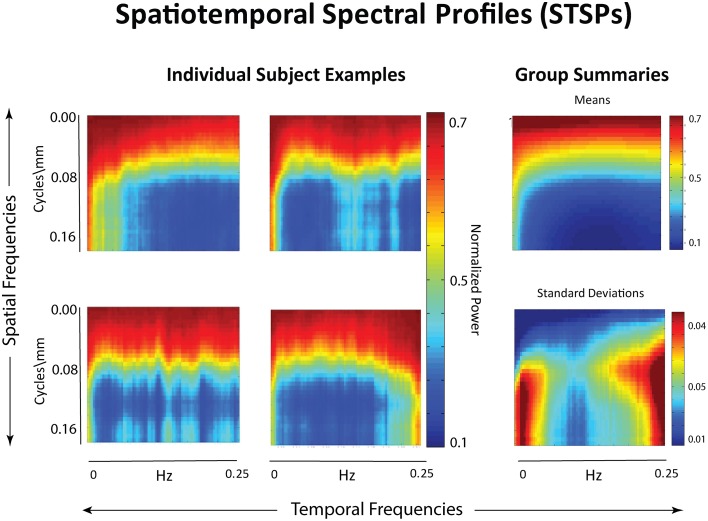
Left: Examples of individual spatiotemporal spectral profiles (STSPs); Right: Means for entire sample (top) and standard deviations (bottom).